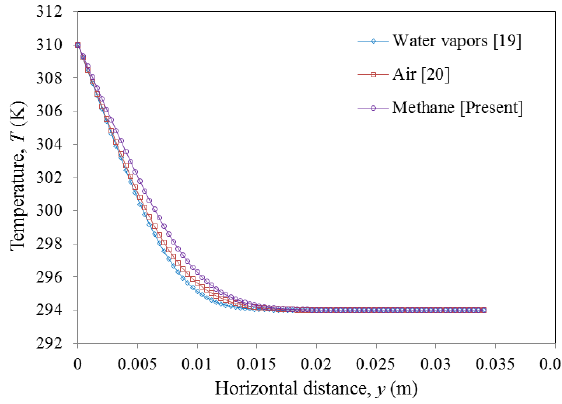
Figure 8. Comparison of temperature profiles of different fluids at location x = 0.5 m